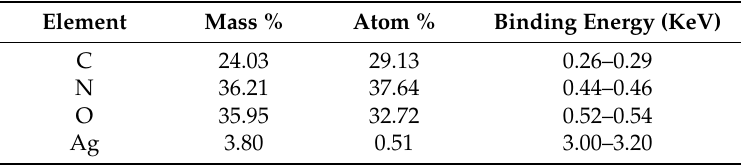
Table 2. The EDX spectroscopic data of the PAN-g-Alg@Ag NC. Element Mass % Atom % Binding Energy (KeV) C